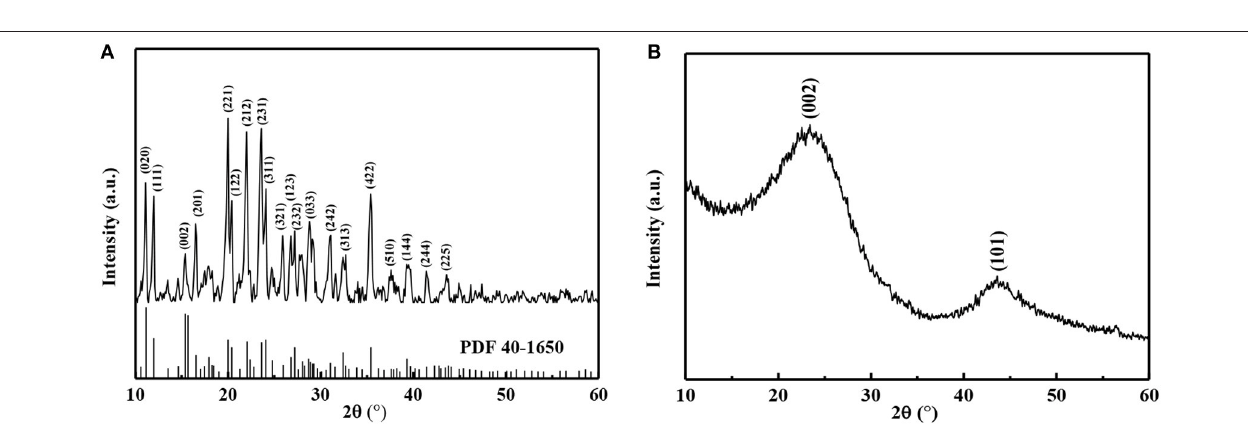
peak at 285.4 eV corresponding to C = C bond disappeared,